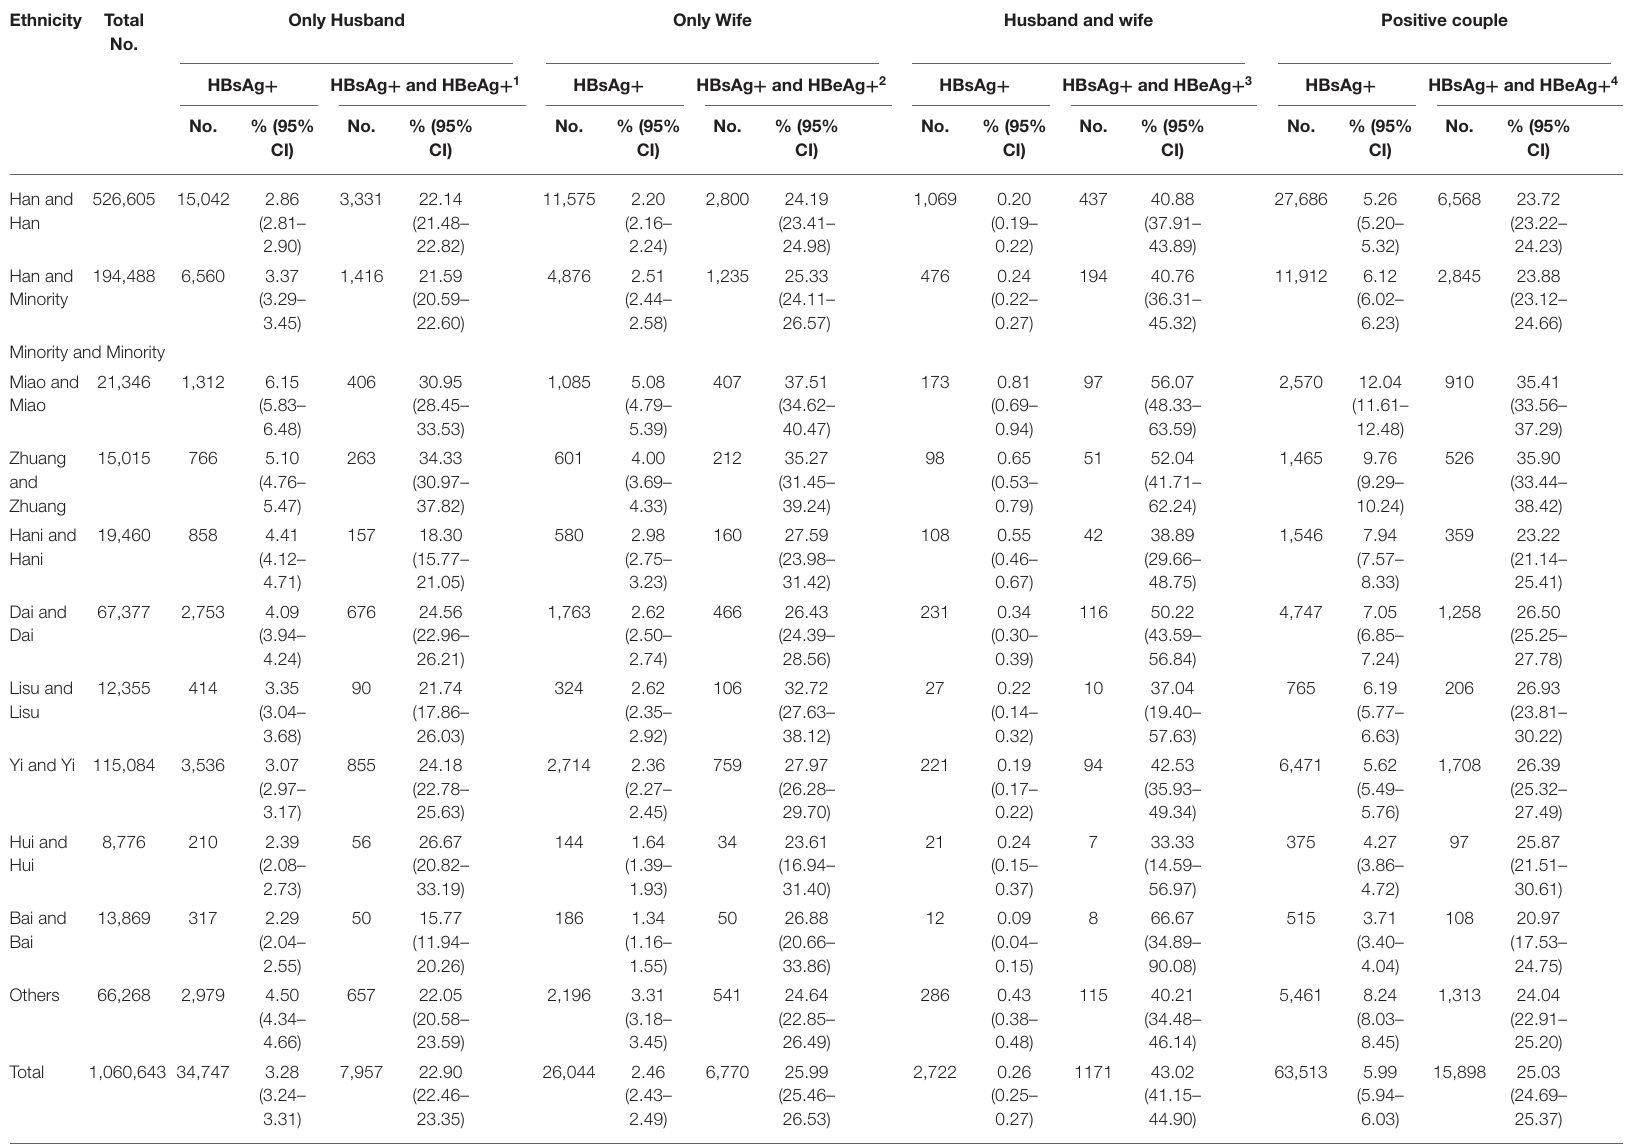
TABLE 2 | Ethnic disparities in hepatitis B surface antigen (HBsAg) and hepatitis B e antigen (HBeAg) status in reproductive-age couples. Ethnicity Total